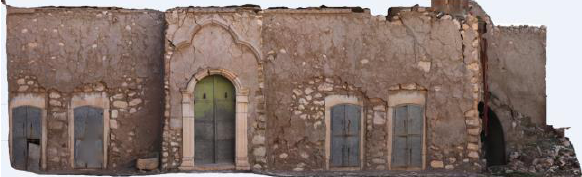
Figure 5. Example of an orthophoto of the northern wall of the Shrine, photogrammetric IBMR technology The orthophoto plan of the Nahum´s shrine and near neighbourhood was processed from the aerial